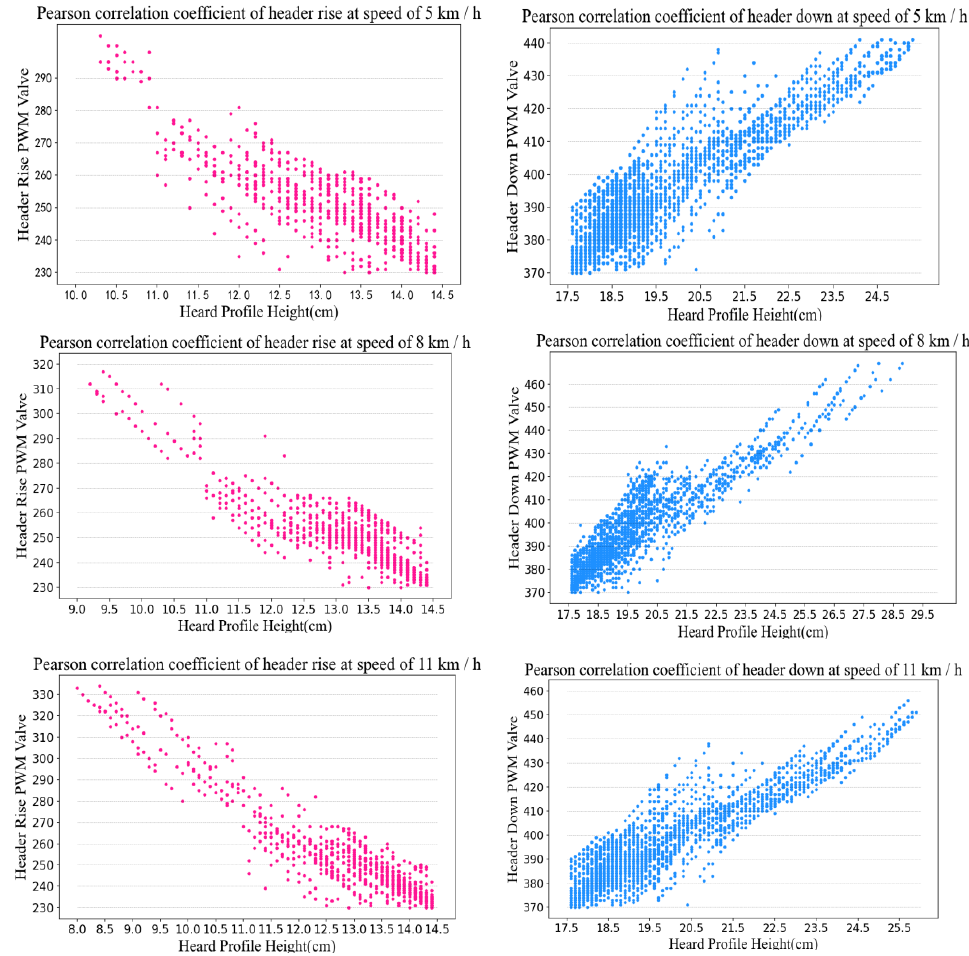
Figure 25. Relationship between control system output PWM value and header height.